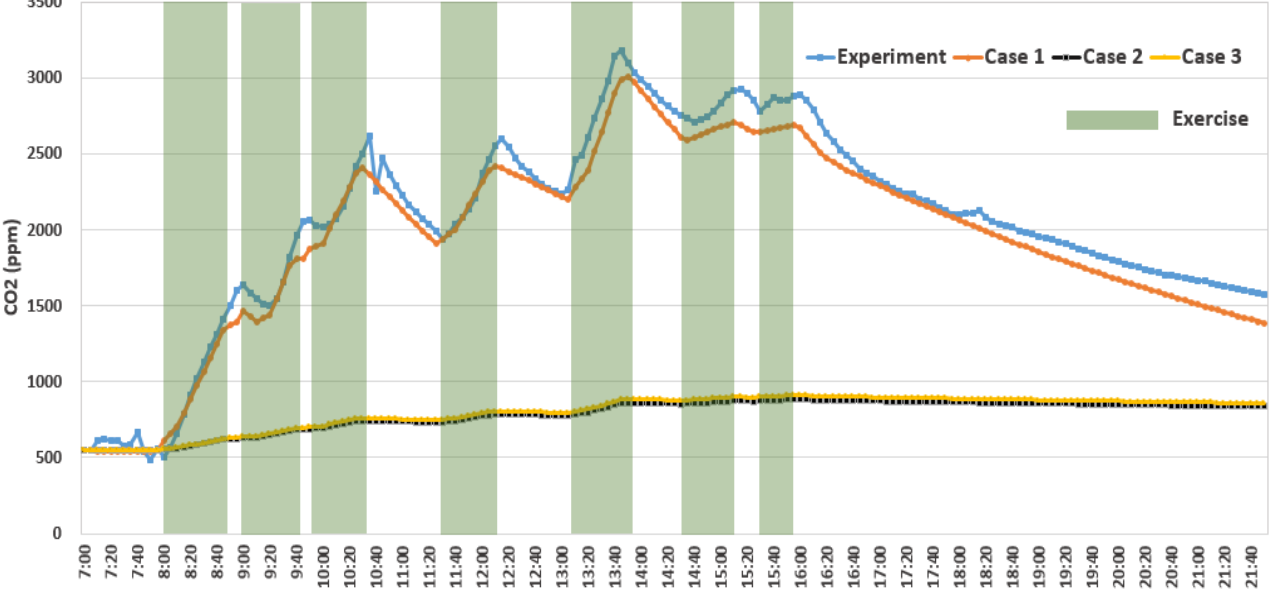
Figure 7. CONTAM simulation of the CO 2 concentration of three cases, with similar conditions as that of the MPA-space of D elementary on 30 that of the MPA-space of D elementary on January 30th.